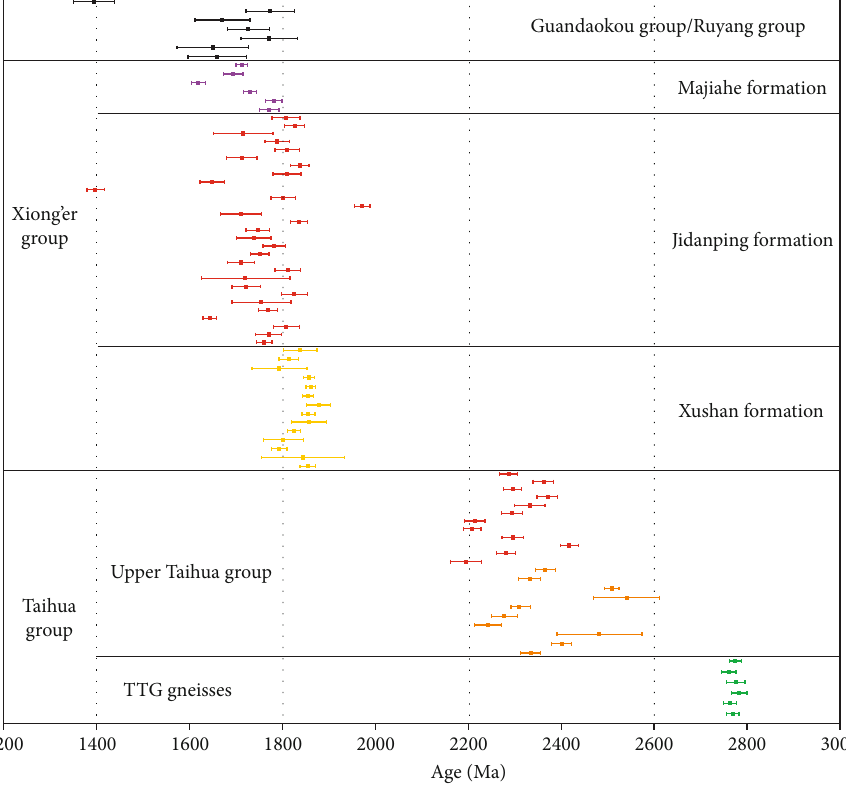
Figure 8: Formation age pedigree chart of volcanic rocks in the Xiong ’ er Group. Data source: this paper, [1, 8, 22 – 24]. Note: the southern margin of the North China Craton is divided by Sanmenxia-Fangcheng-Xinyang. The west is the Ronan Basin, and the upper strata of Xiong ’ er Group are the Guandaokou Group. The eastern is the Ruyang Basin, and the upper strata of Xiong ’ er Group are the Ruyang